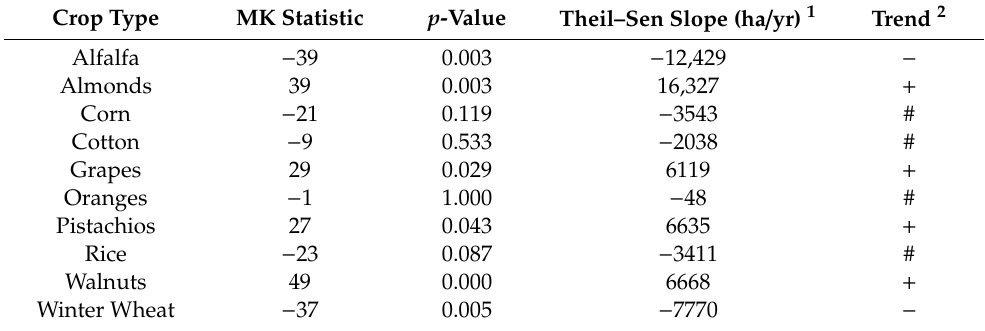
Table 3. Simple Mann–Kendall trend test results for CDL crop area in the Central Valley from 2008 to 2018 for the top 10 major crops showing: (1) Mann–Kendall trend statistic, (2) p -value, (3) Theil–Sen slope (ha / year) from 2008 to 2018, and (4) the significant trend where ( + ) and ( − ) indicate statistically significant increasing or decreasing trends, respectively, where the p -value is less than 0.05